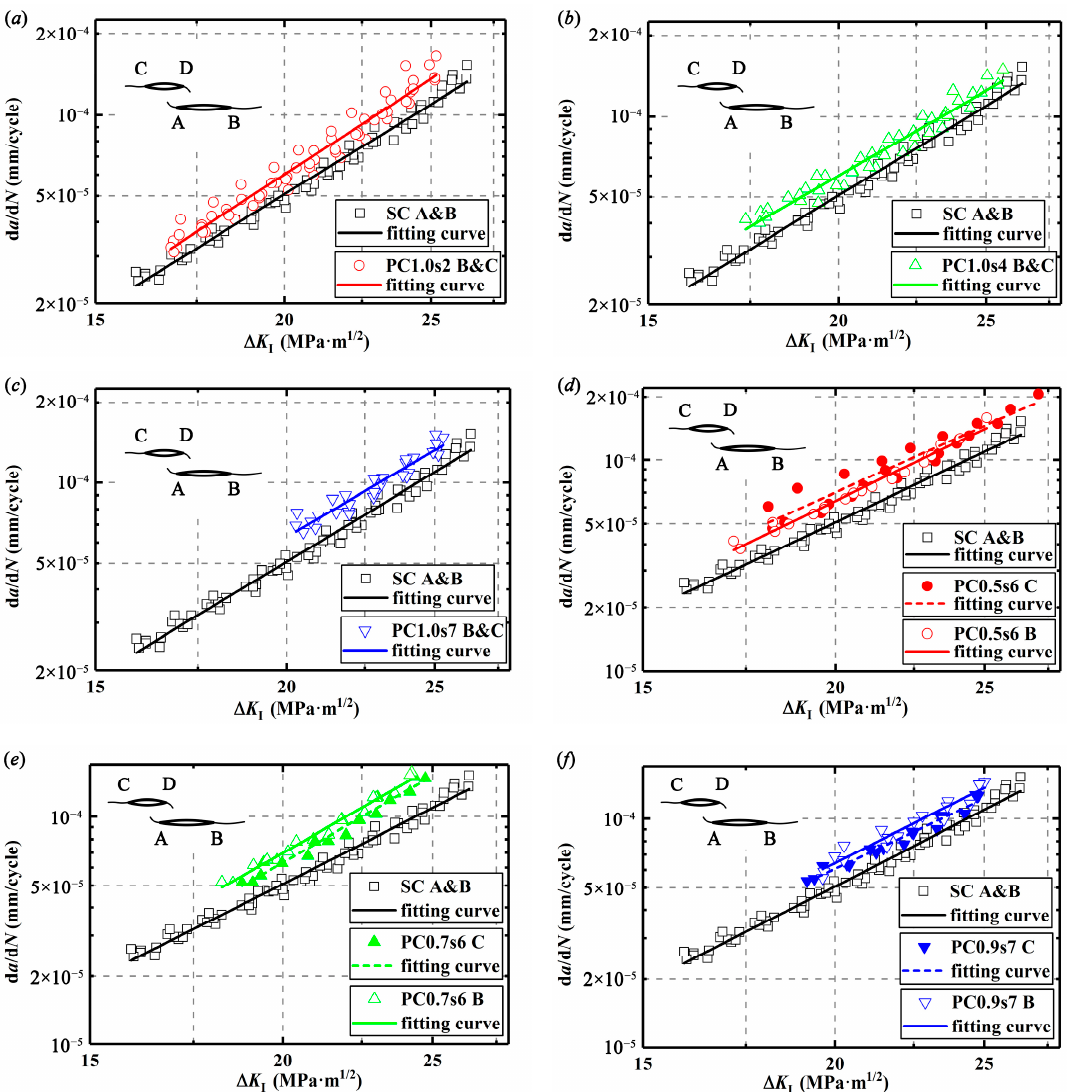
Figure A1. d a / d N vs ∆ K I for di ff erent specimens: ( a ) SC and PC1.0s2, ( b ) SC and PC1.0s4, ( c ) SC and Figure A1. d a /d N vs Δ K I for different specimens: ( a ) SC and PC1.0s2, ( b ) SC and PC1.0s4, ( c ) SC and PC1.0s7, ( d ) SC and PC0.5s6, ( e ) SC and PC0.7s6, and ( f ) SC and PC1.0s7, ( d ) SC and PC0.5s6, ( e ) SC and PC0.7s6, and ( f ) SC and PC0.9s7.